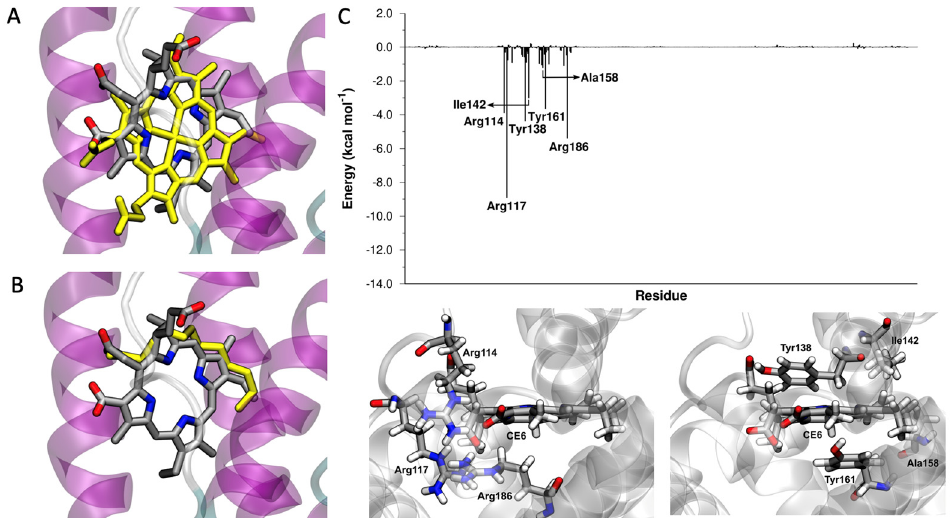
Figure 4. ( A ) A superposition of the crystallographic structure of heme (in yellow, PDB:1O9X) and a docked structure of Ce6 in the heme binding pocket; ( B ) a superposition of the crystallographic structure of myristic acid (in yellow, PDB:1BJ5) and a docked structure of Ce6 in the heme binding pocket; ( C ) Ce6 − HSA interactions in the heme binding pocket. Δ E binding decomposed per residue. A 3D representation of the most interacting residues.